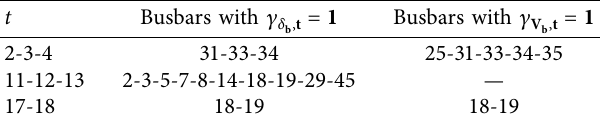
Table 10: Values of binary coefcient c work in scenario